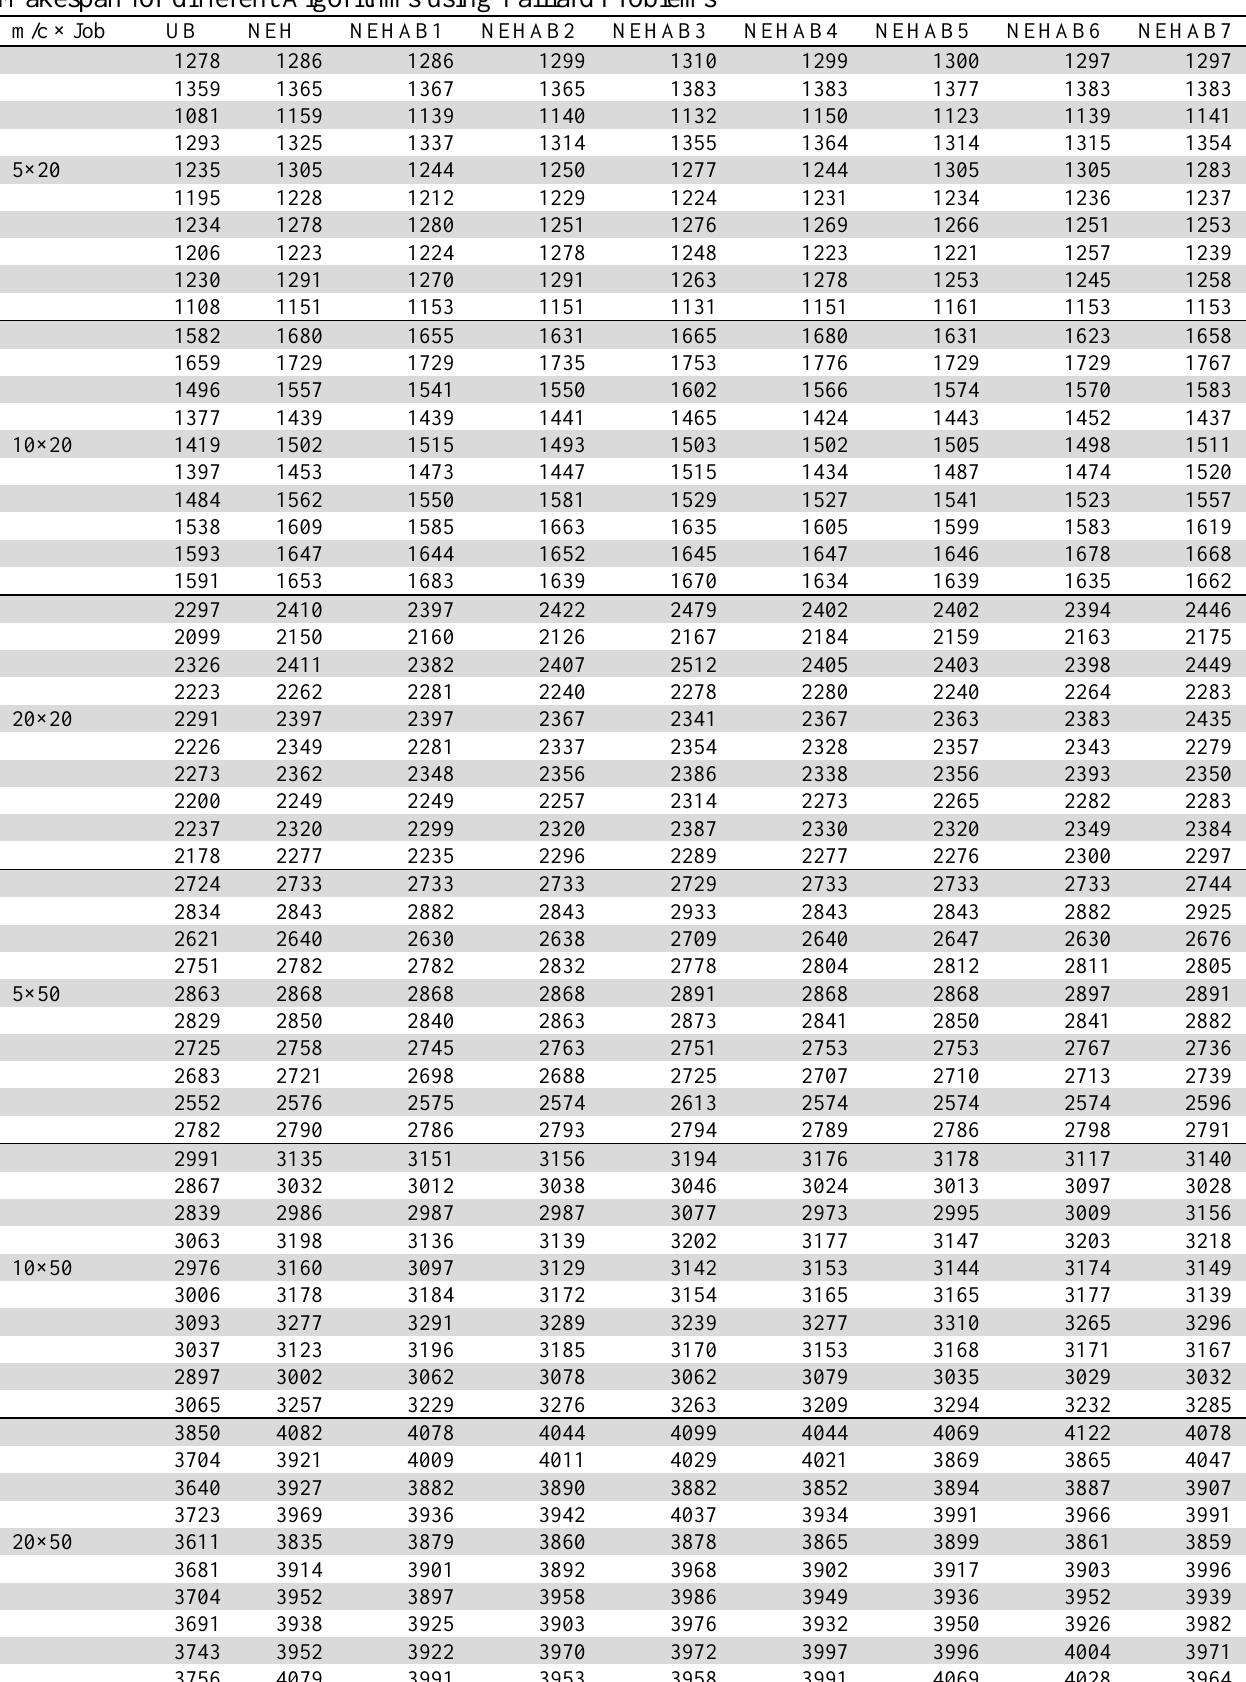
Table 2 Makespan for different Algorithms using Taillard Problems m/c ×